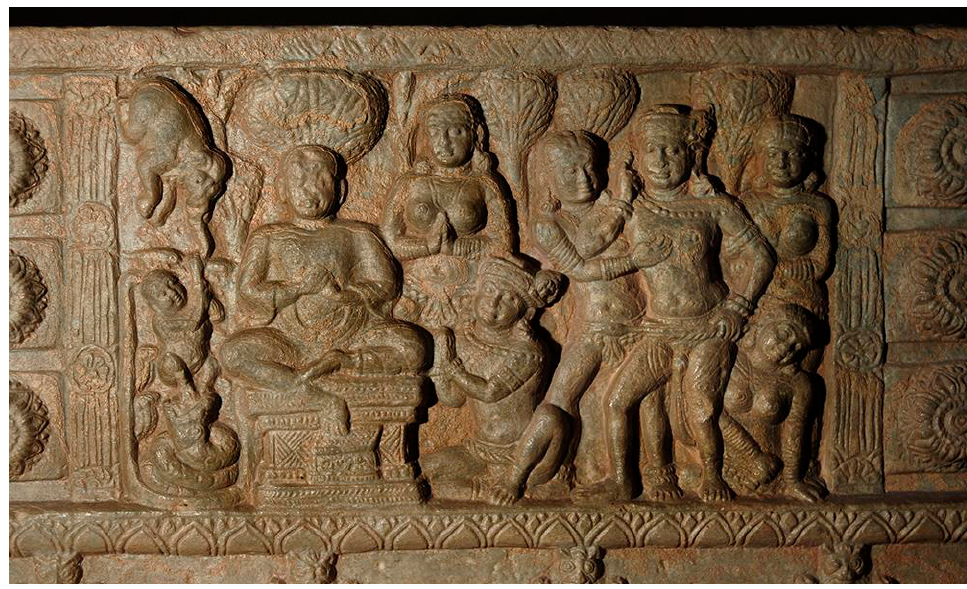
Figure 15. Nagarjunakonda, Archaeological Site Museum, no. 24 © photograph Wojtek Oczkowski with kind permission of ASI.